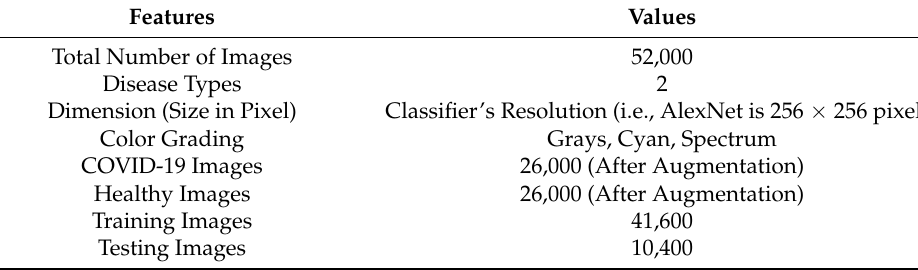
Table 3. Dataset